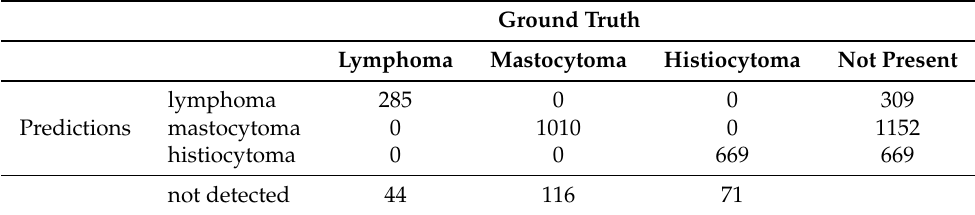
Table 4. Extended confusion matrix for the best model for the ’divided’ dataset.